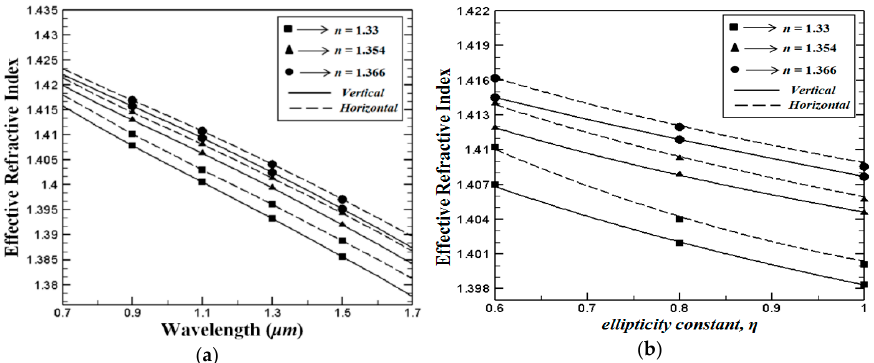
Figure 2 . ( a ) Wavelength depending effective refractive index of the fundamental (cid:1834)(cid:1831) (cid:2869)(cid:2869) (cid:3051) mode, where η = 0.7, and ( b ) the effective refractive index of the fundamental (cid:1834)(cid:1831) (cid:2869)(cid:2869)(cid:3051) mode as a function of ellipticity constant η , where the wavelength is fixed to λ = 1.